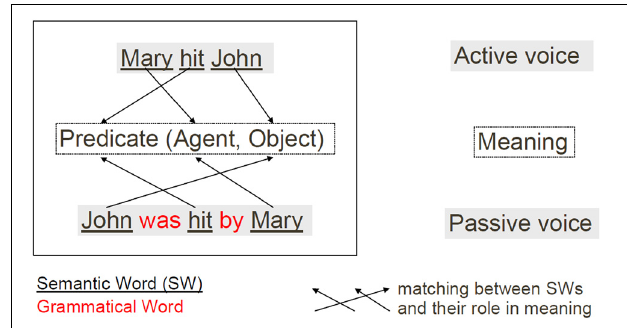
FIGURE 1 | Schematic characterization of the thematic role assignment task. Solving this task consists in finding the adequate mapping between the content words (i.e., semantic words) and their roles in the meaning of a given sentence. This mapping is represented by the set of arrows (here three) for each sentence surface-meaning